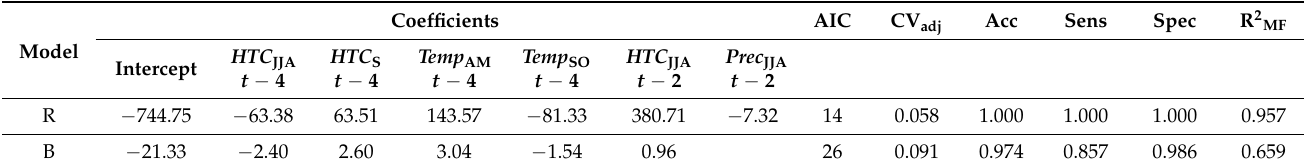
Table 1. Logistic regression analysis. For each model, we indicated the predictor coefficients, AIC, adjacent cross-validation estimate of prediction error (CV adj ), accuracy (Acc), sensitivity (Sens), specificity (Spec), and adjusted McFadden’s pseudo-R 2 (R 2 MF ).